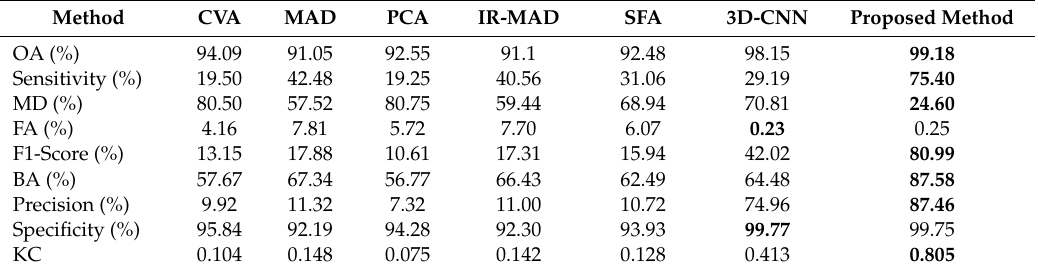
Table 9. The accuracy of different change detection methods for the Multispectral-Saclay dataset (the best performance for each method appears in bold).